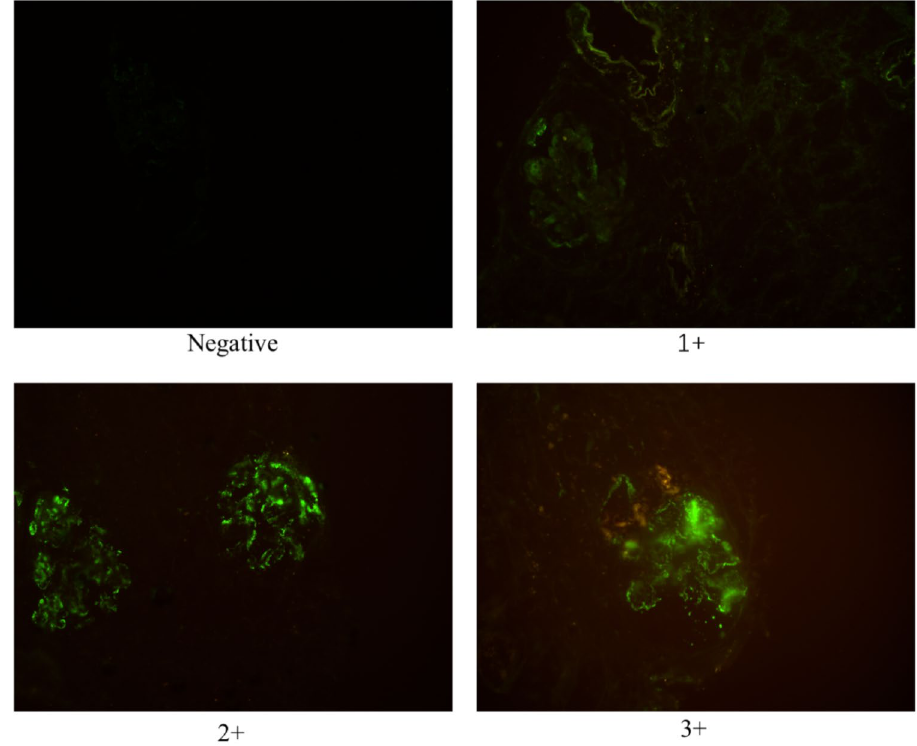
Figure 4. C1q deposition in the mesangium from negative to 3 + (original magnification ×